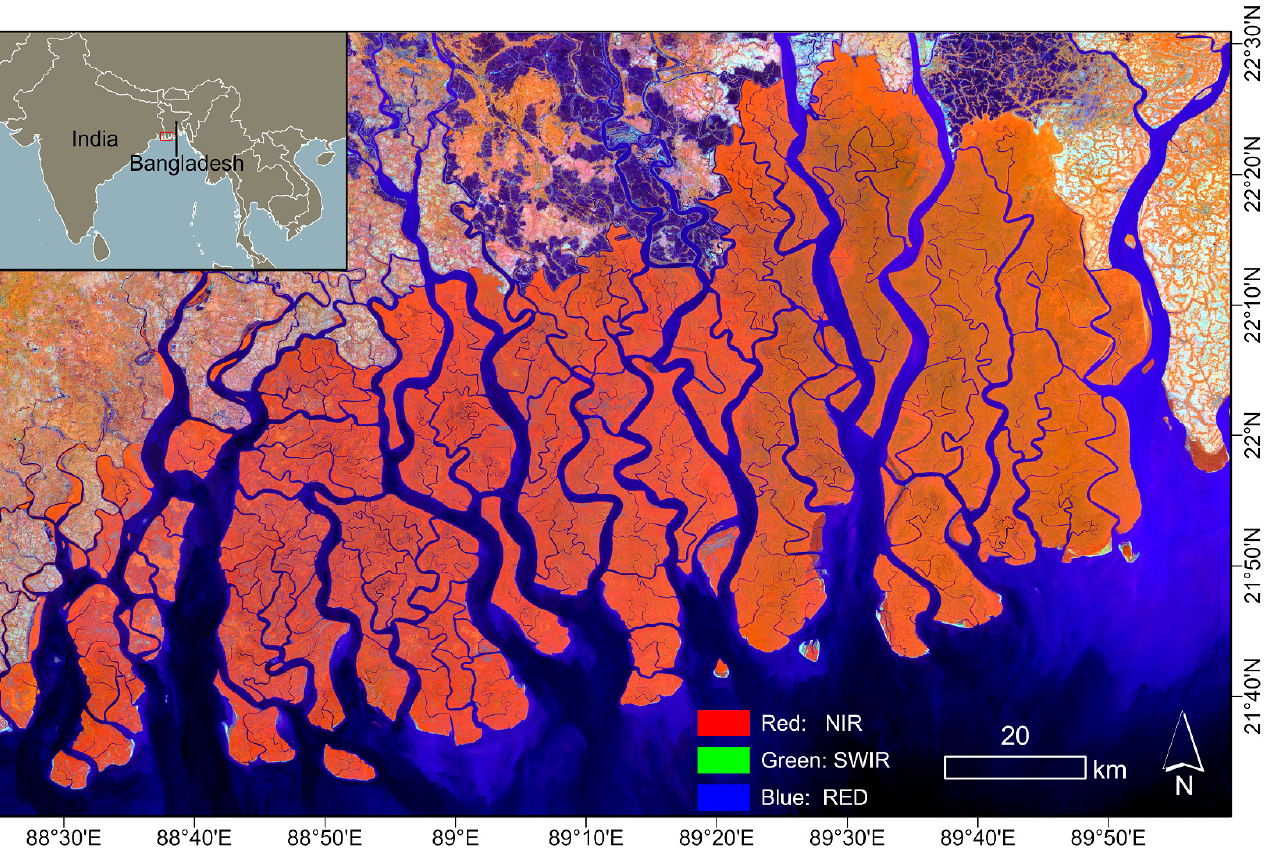
Figure 1. Map of the study area and its location encompassing the India–Bangladesh border. The false-color (near-infrared (NIR), shortwave infrared band 1 (SWIR), and red bands as RGB) image was obtained from Landsat-8 median composite in 2022.